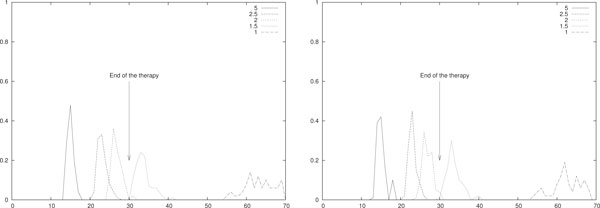
Probability density function, daily ACI mono-therapy. Empirical evaluation of ϱ(ter) for different piece-wise constant (left) and impulsive (right) daily ACIs. In (left) bi = w* · 104/(V A) for i = 1, . . . , 30 and in (right) wi = w* · 104 for i = 1, . . . , 30 where w* ∈ {5, 2.5, 2, 1.5, 1}. The value of w* is given in the figure, all the other parameters are as in Table 3. The densities are obtained by performing 102 simulations for each value of w*.